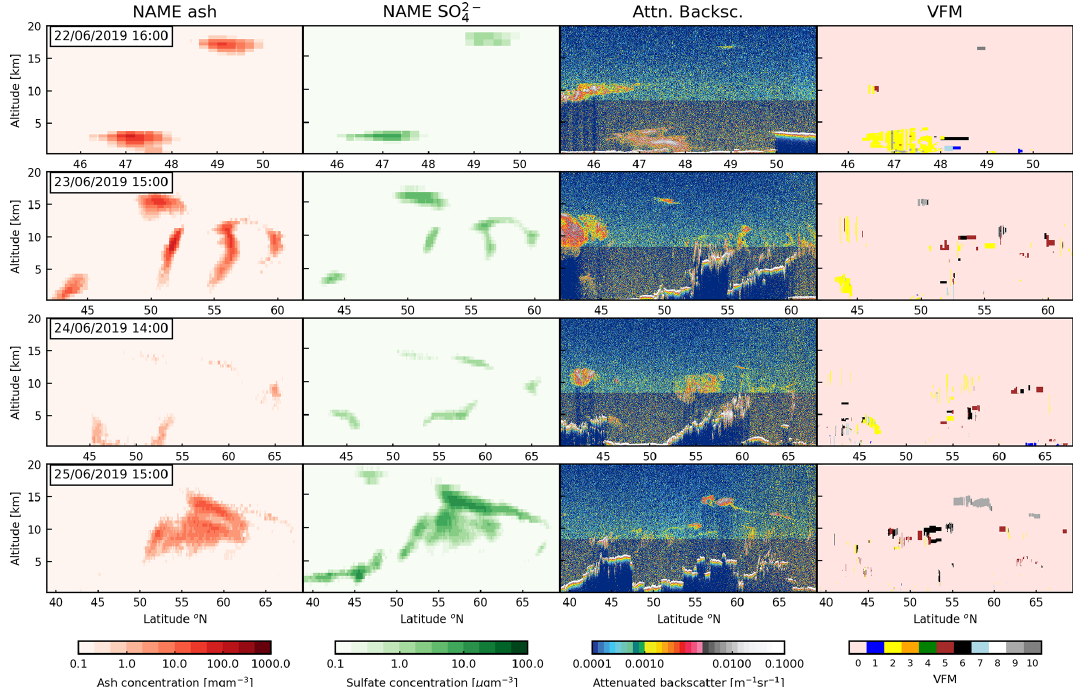
Figure 4. Columns one and two: vertical distribution of simulated ash and sulfate aerosol clouds along the CALIPSO tracks shown in Fig. 3; column three: CALIPSO total attenuated backscatter at 532nm; column four: CALIPSO VFM. The model data are taken from the 1h output file closest to the time of the CALIPSO overpass. Key to VFM colour bar: 0 means not applicable, 1 means marine, 2 means dust, 3 means polluted continental/smoke, 4 means clean continental, 5 means polluted dust, 6 means elevated smoke, 7 means dusty marine, 8 means polar stratospheric cloud aerosol, 9 means volcanic ash and 10 means